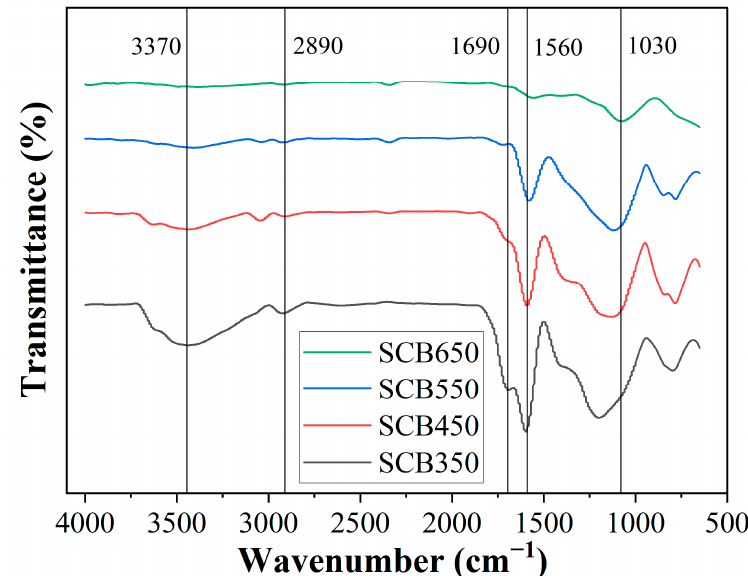
Figure 1. FTIR spectra of sugarcane biomass pyrolyzed at various temperatures.